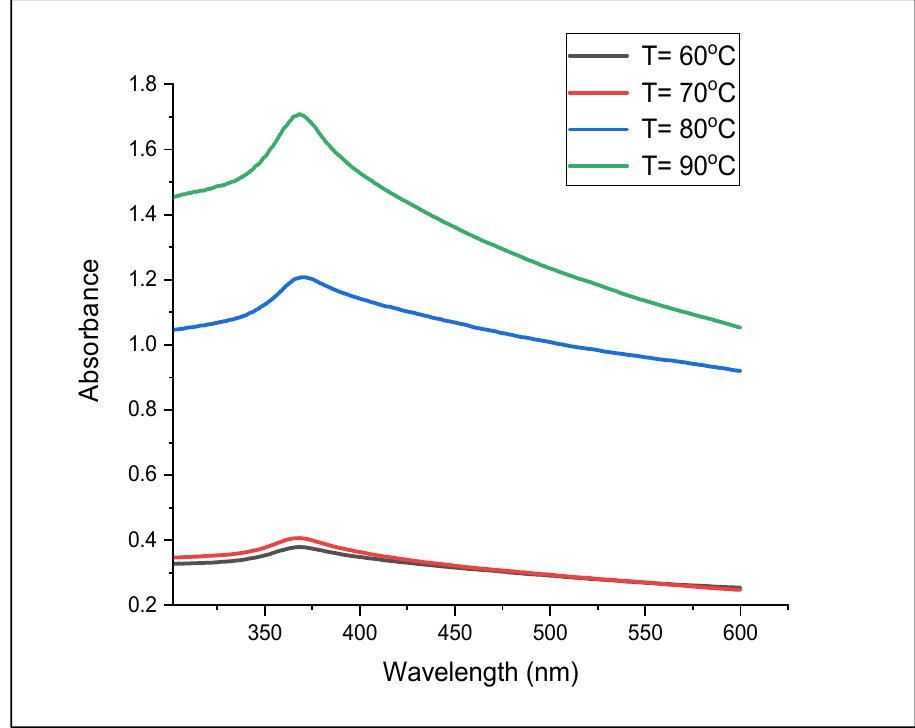
Figure 4. UV-Vis Spectra showing the effect of temperature on ZnO nanoparticle synthesis.